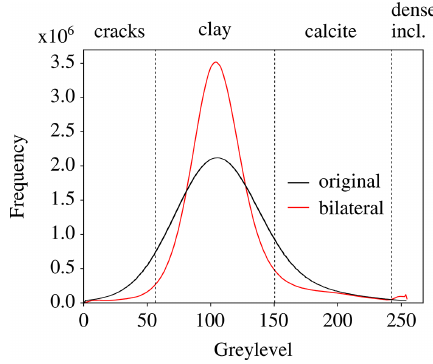
Figure B2. Grey value histogram of the original horizontal X-ray slice and after the application of bilateral filter of Fig. B2a.